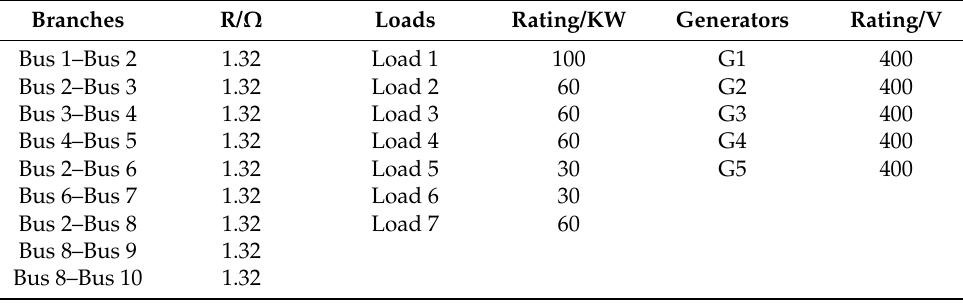
Table A1. Data of the simulated DC microgrid. Branches R/ Ω Loads